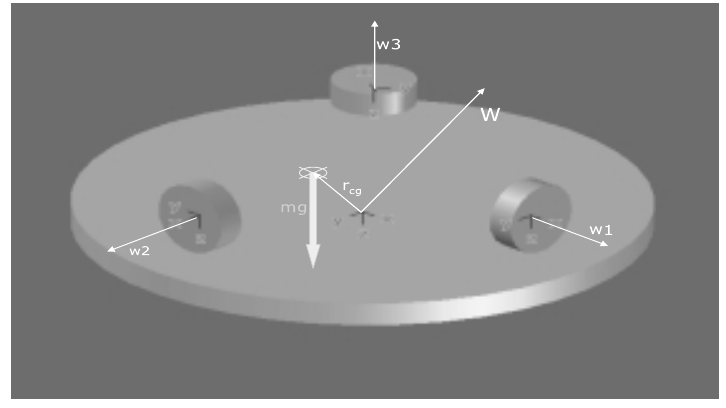
Fig. 1. Satellite Attitude Control System Simulator